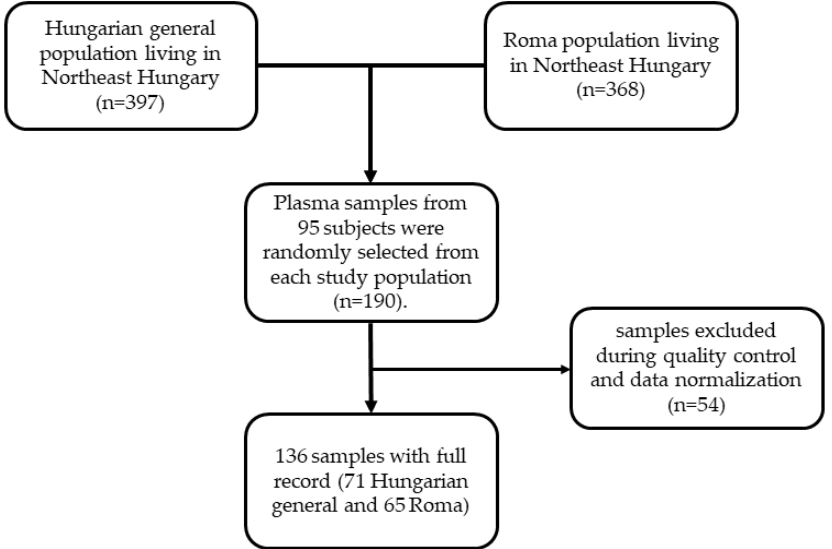
Figure 1. Flowchart showing the selection of study population and plasma samples for lipidomic analysis.